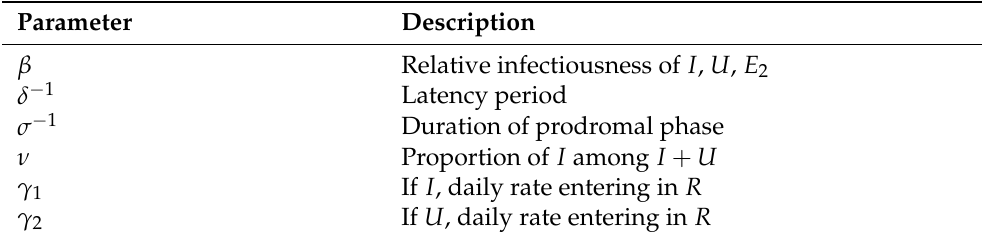
Table 4. Description of the parameters involved in model SE 2 IUR